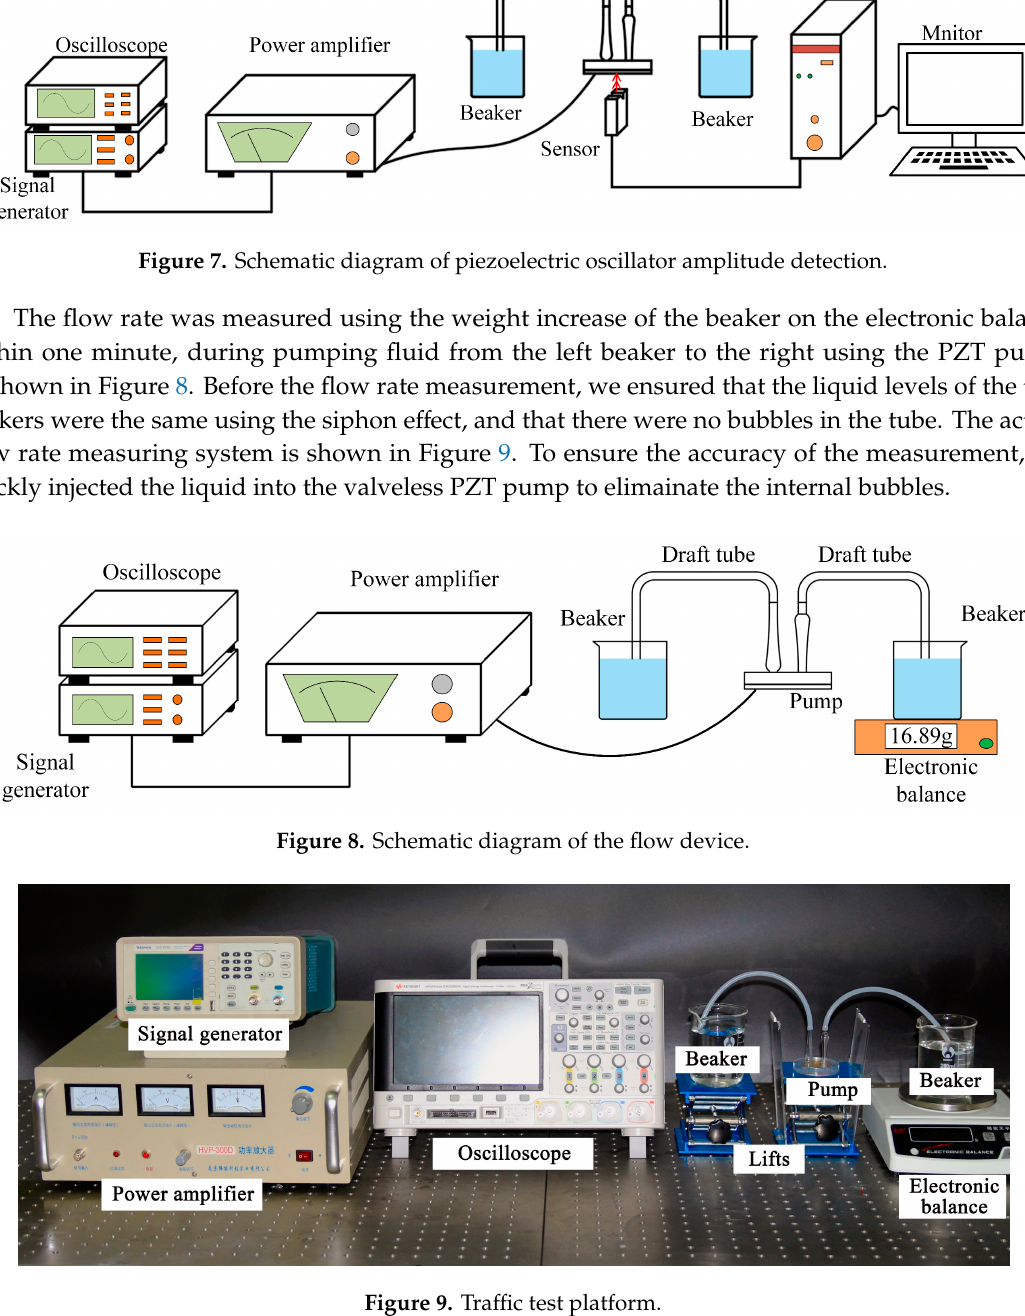
Figure 9. Traffic test platform. Figure 9. Tra ffi c test